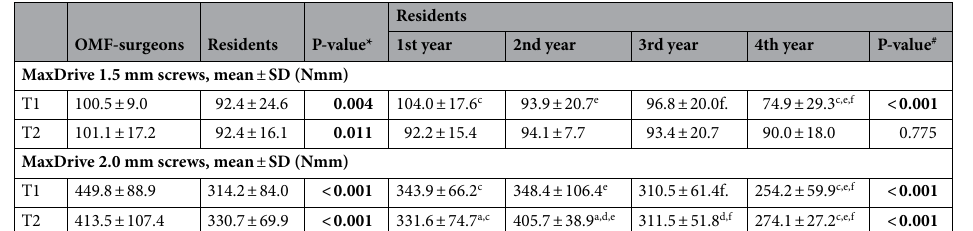
Table 2. The torque applied by experienced OMF-surgeons and residents at T1 and T2. The bold P-values represent statistically significant differences. Each superscript denotes significant differences in the pairwise comparisons (see P-values below): ‘a’ is derived from the pairwise comparison between first- and second-year residents, ‘b’ between first- and third-year residents, ‘c’ between first- and fourth-year residents, ‘d’ between second- and third-year residents, ‘e’ between second- and fourth-year residents, and ‘f’ between third- and fourth-year residents. 1.5 mm screws at T1: a P = 0.502; b P > 0.999; c P < 0.001 ; d P > 0.999; e P = 0.008 ; f P = 0.001. 1.5 mm screws at T2: non-significant differences between subgroups and, thus, no pairwise comparisons were performed. 2.0 mm screws at T1: a P > 0.999; b P = 0.551; c P < 0.001 ; d P = 0.335; e P < 0.001 ; f P = 0.029. 2.0 mm screws at T2: a P < 0.001 ; b P = 0.790; c P < 0.001 ; d P < 0.001 ; e P < 0.001 ; f P = 0.034. SD standard deviation; OMF- surgeons oral and maxillofacial surgeons. *Comparison between OMF-surgeons and residents. # Comparison between the residency years.